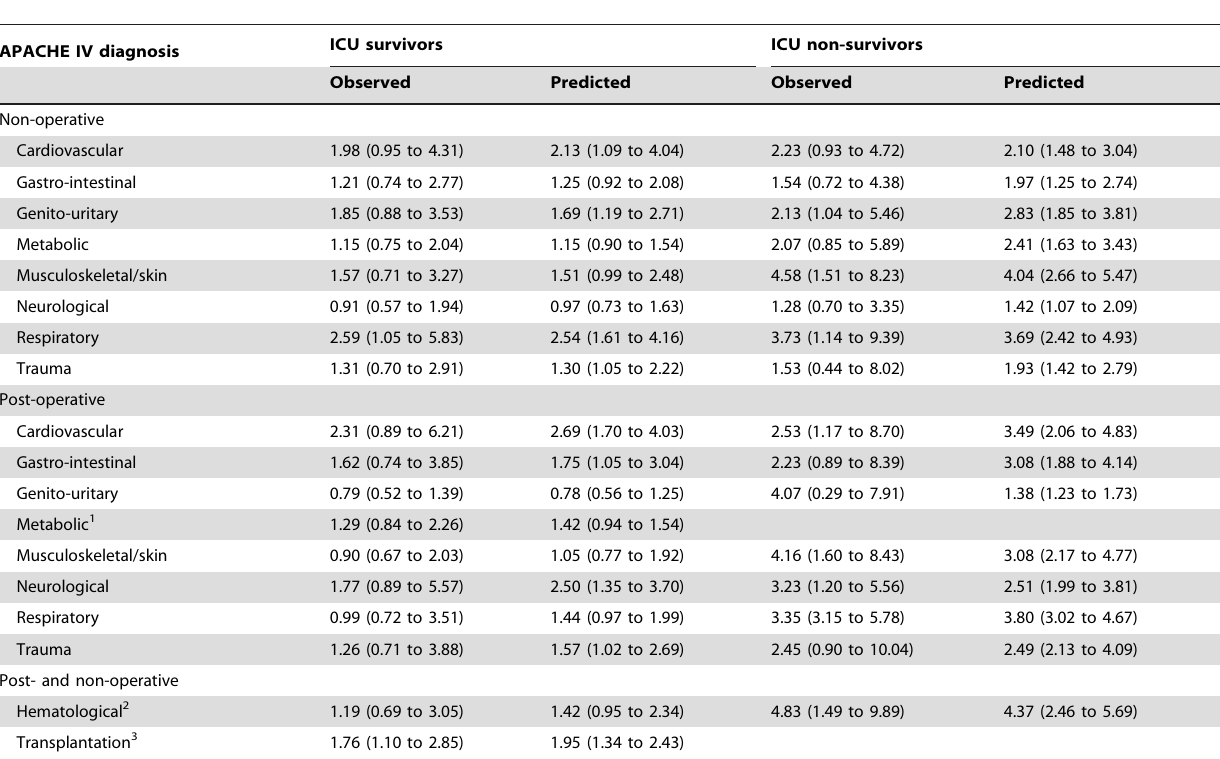
Table 3. Observed and predicted ICU LoS (median (IQR)), for ICU survivors and ICU